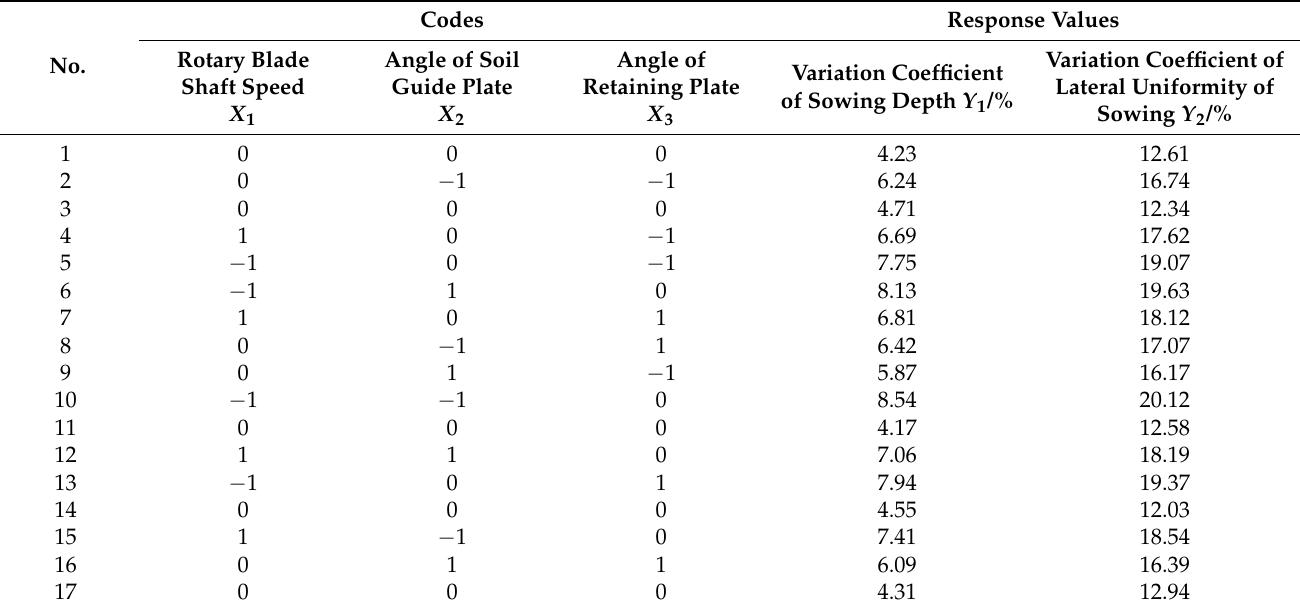
Table 4. The data were analyzed by quadratic polynomial regression with Design-expert 12.0 software, and the correlation and interaction effects of various factors were analyzed by response surface analysis. Table 4. Experiment design and response values.